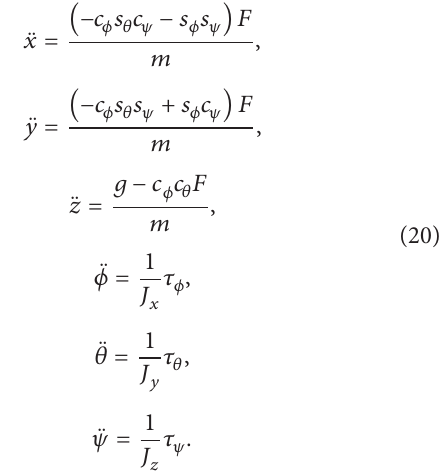
be neglected. So the dynamics of the quadrotor is simplified and given as